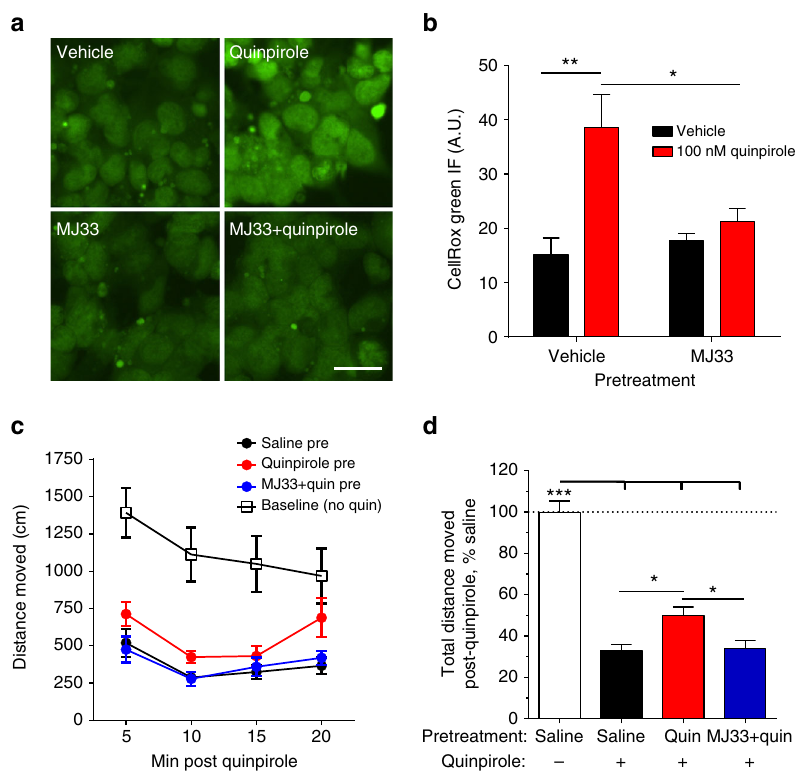
Fig. 5 D2 dopamine receptor tolerance is mediated by PRDX6-dependent ROS production. a HEK293 cells transiently expressing HA-D2DR(L) were pretreated with vehicle or MJ33 (10 µ M) 30 min prior to being treated for 1 h with vehicle or quinpirole (100 nM). Cells were imaged for ROS using CellROX Green; scale bar represents 12.5 µ m. b Quanti fi cation of ROS in a . Quinpirole increased CellROX Green fl uorescence; this was blocked by pretreatment with MJ33 (two-way ANOVA, signi fi cant effect of quinpirole ( P < 0.01) and signi fi cant interaction ( P < 0.05), n = 4 – 5; * P < 0.05, ** P < 0.01, Holm – Sidak post hoc analysis of MJ33 vs. vehicle pretreatment). c , d Mice were injected with saline or MJ33 (1.25 mg kg − 1 i.p.) 1 h prior to the initial injection of quinpirole (0.2 mg kg − 1 i.p.) or saline. Two hr later, mice were injected with a quinpirole (0.2 mg kg − 1 i.p.) or saline (baseline) placed in a novel cage, and locomotor activity was measured over 20 min. c Locomotion was measured as distance traveled (cm), in 5 min bins. Pretreatment signi fi cantly affected locomotion. (two-way ANOVA, signi fi cant effect of treatment ( P < 0.001), time ( P < 0.001), and signi fi cant interaction ( P < 0.01), n = 7 –